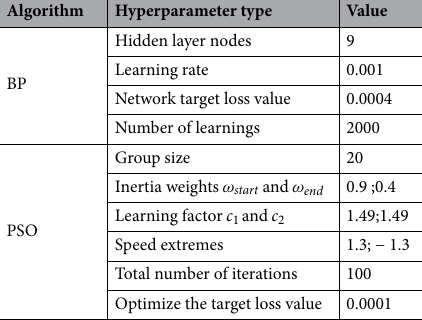
Table 1. Superparameter